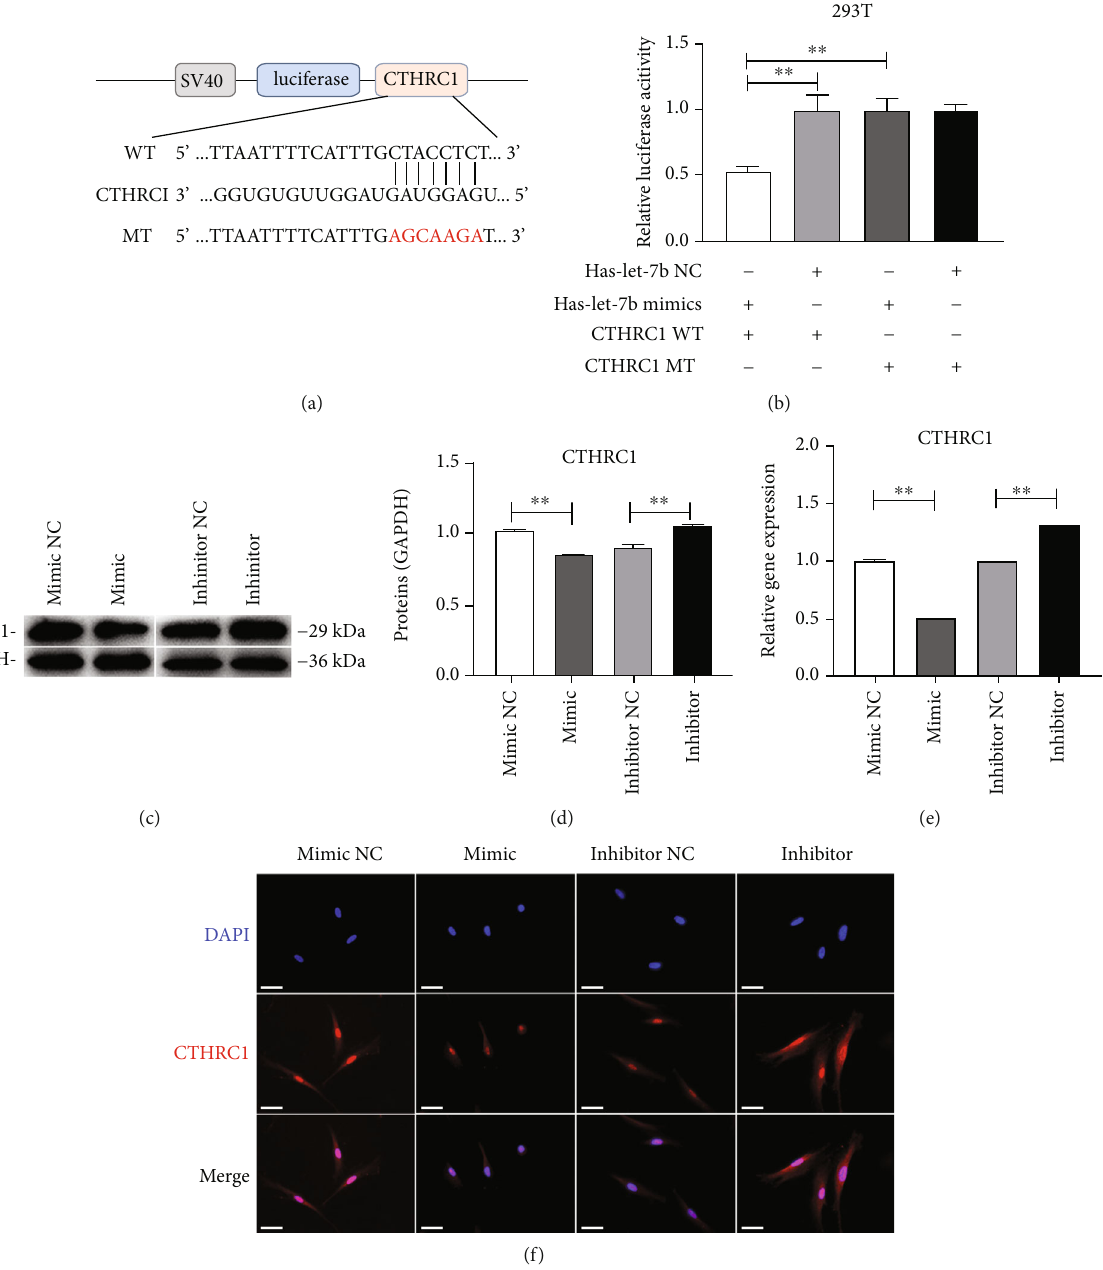
Figure 5: CTHRC1 is a direct target of hsa-let-7b . (a) The wild-type CTHRC1-3 ′ -UTR (WT) and mutant CTHRC1-3 ′ -UTR reporter plasmid (MUT) were constructed. (b) Luciferase reporter assays in 293 T illustrated that hsa-let-7b could bind with CTHRC1. (c – e) Western blot and qRT-PCR analysis were performed to detect the protein and mRNA levels of CTHRC1 in group mimic NC, mimic, inhibitor NC, and inhibitor at day 3, respectively. ∗∗ P < 0 : 01 . (f) The immuno fl uorescence staining of CTHRC1 in transfected PDLSCs and matched controls ( scale bar = 50 μ m